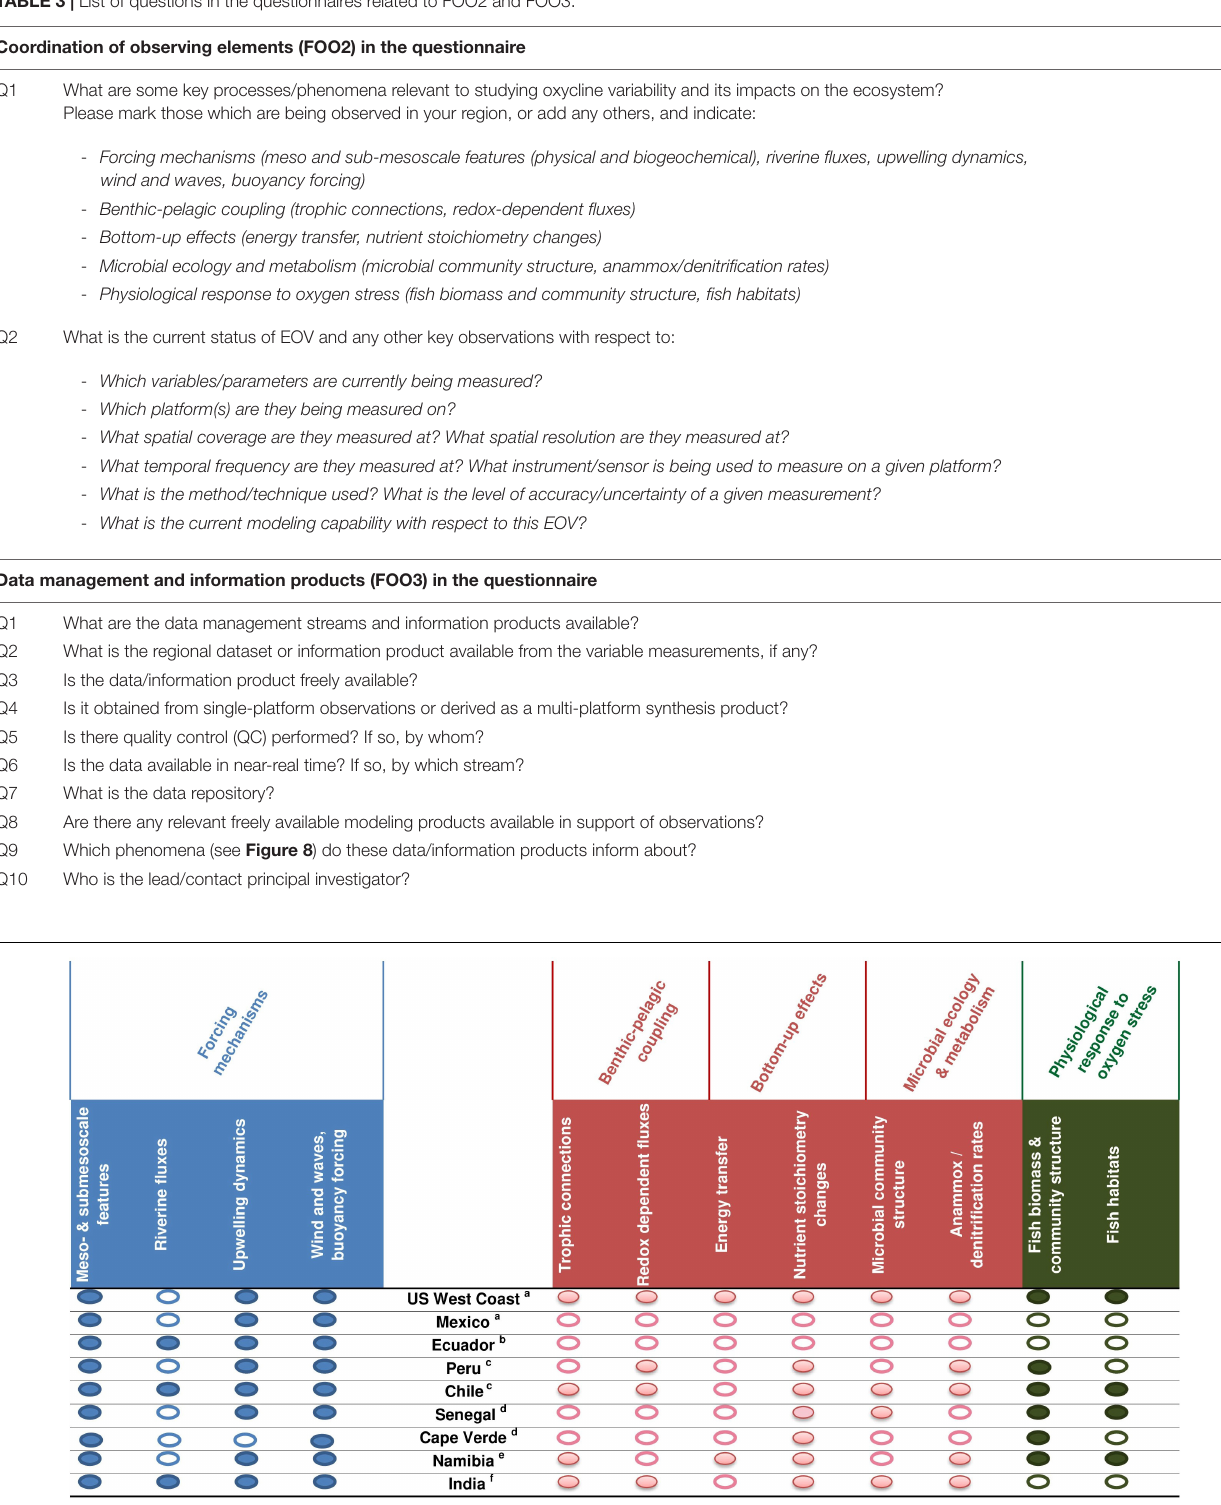
FIGURE 8 | Key phenomena relevant for studying oxycline variability and its impacts on the ecosystem as documented for each oxygen minimum zone (OMZ) selected region, and based on the questionnaire responses. Symbols as in Figure 5 .